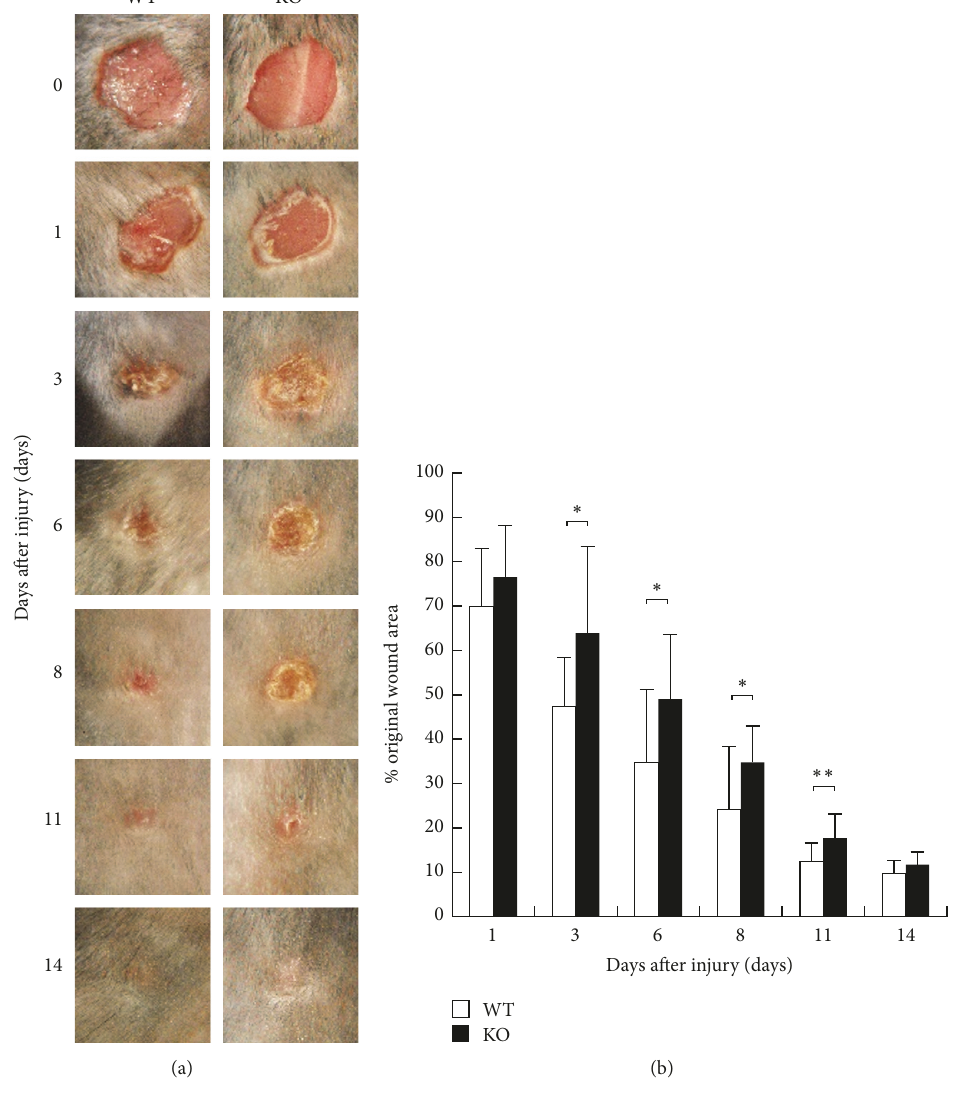
Figure 1: (a) Macroscopic wound findings of cutaneous excision wound healing in dorsal skin of inducible nitric oxide synthase (iNOS-) knockout (KO) mice and wild type (WT) mice. (b) Unhealed wound area changed in percentage to the original wound area in each time point. At the time points of 3, 6, 8, and 11, the remaining skin defect was larger in KO mice than WT mice with a statistically significant difference. Open bars: WT, filled bars: KO ( 𝑛 = 7 animals in each group). Mean ± standard deviation. ∗ 𝑝 < 0.05 ; ∗∗ 𝑝 < 0.01